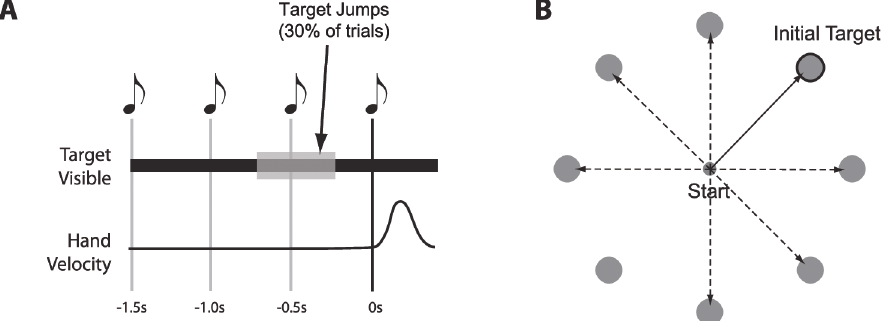
Solid arrow/bold target indicates movement required before target jump. Dashed arrows indicate potential movements required after a target